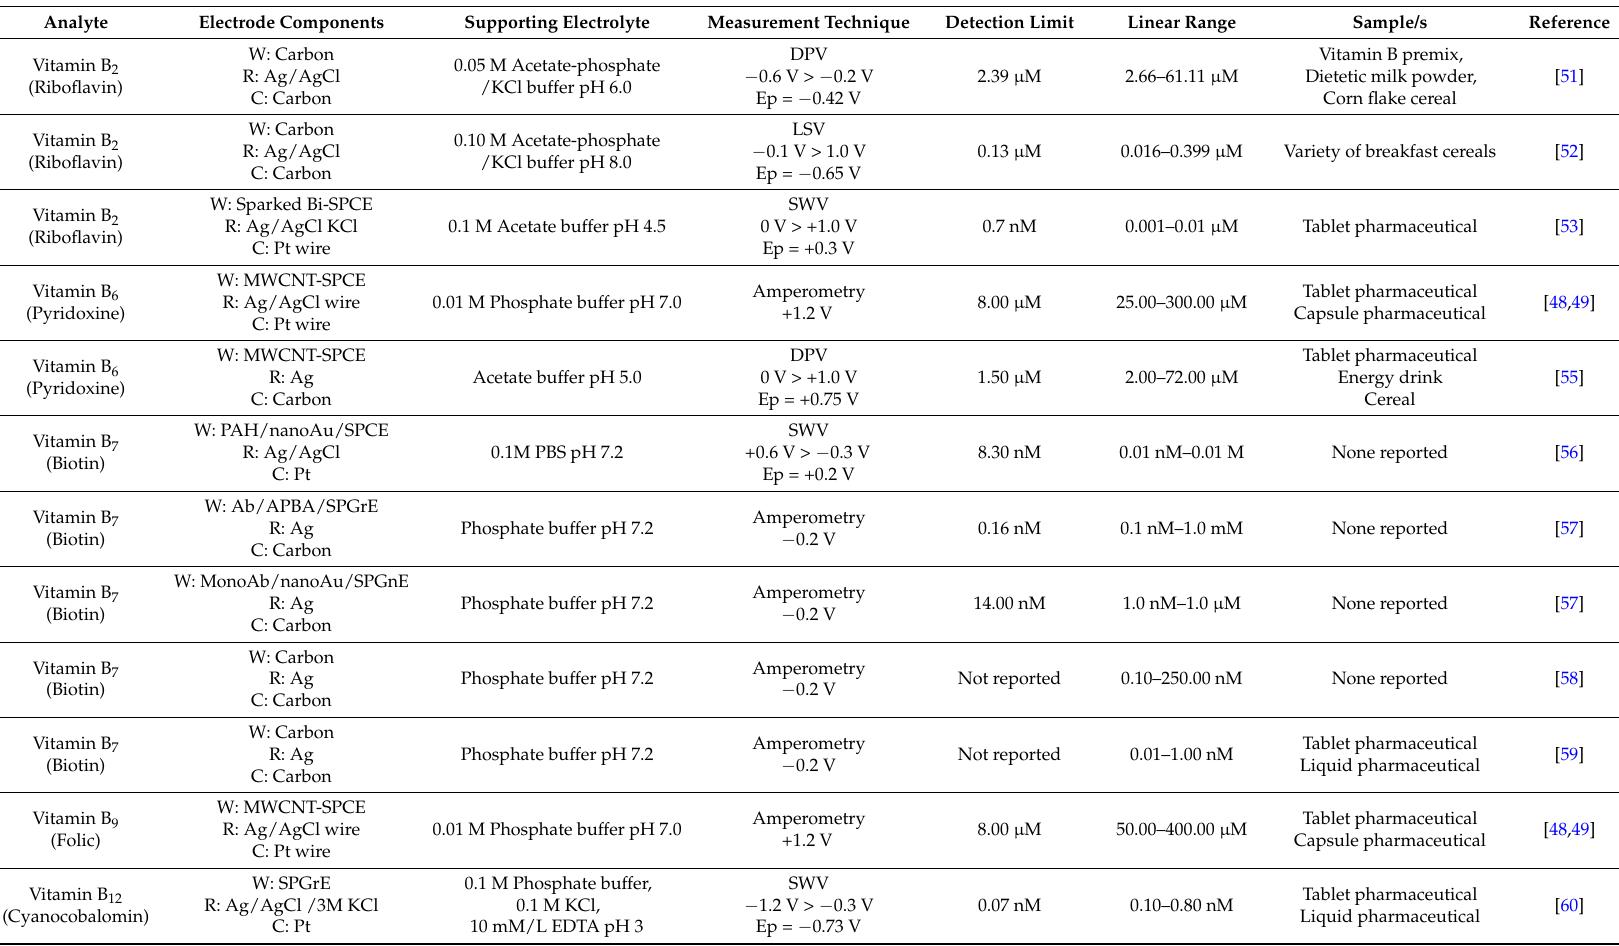
Table 6. Reports of screen-printed sensors for vitamin B